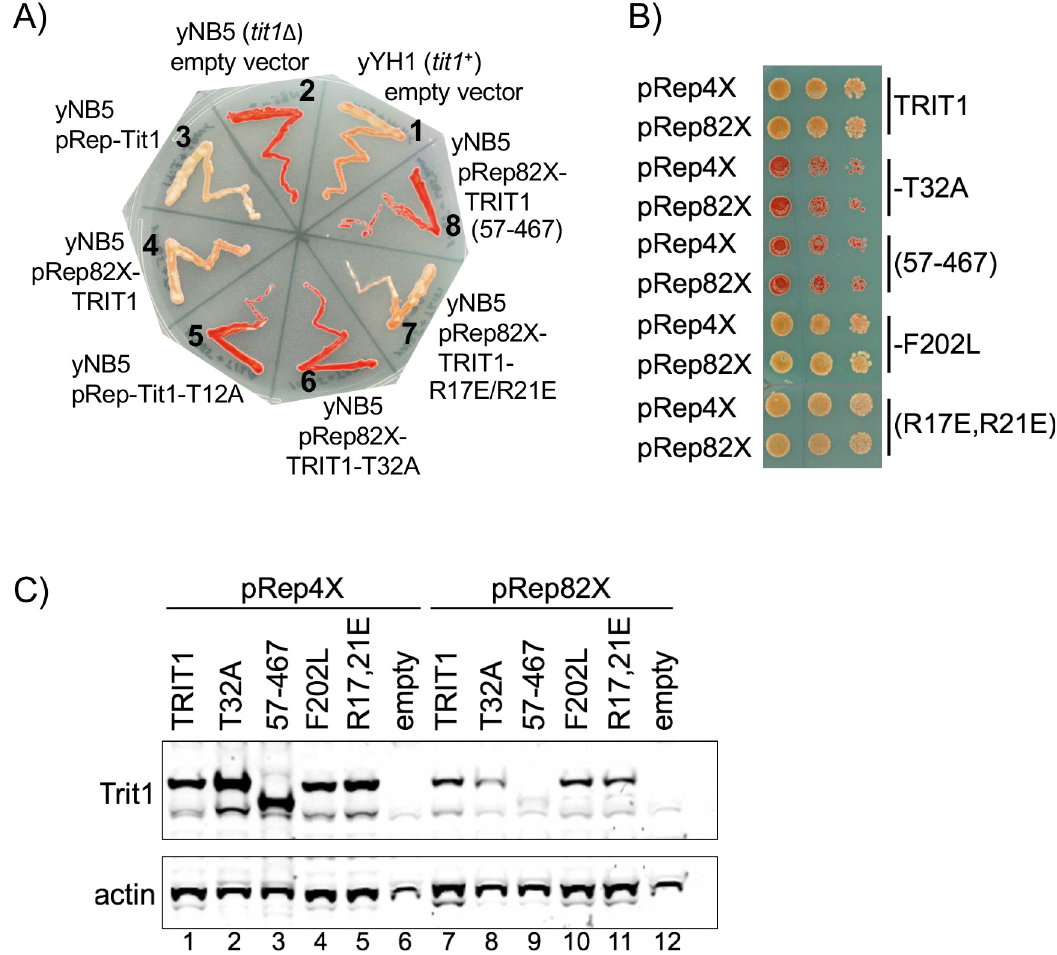
Fig 5. Determinants of TRIT1 critical for cy-tRNA Ser UCA-mediated TMS in S . pombe . A) Cy-tRNA Ser UCA-mediated TMS assay in S . pombe yNB5 ( tit1 Δ ) transformed with the empty plasmid pRep82X (sector 2) or plasmids expressing the proteins indicated (sectors 3–8), and the tit1 + control strain, yYH1 (sector 1). B) TMS assay as in A but displayed as dilution spot assay, for plasmids expressing TRIT1 and variants from pRep82X and from the stronger nmt1 + promoter (pRep4X) as indicated on the left. C) Western blot of extracts of cells in B detected with anti-TRIT1 (top panel), and anti-actin antibody; lanes numbers are indicated below actin